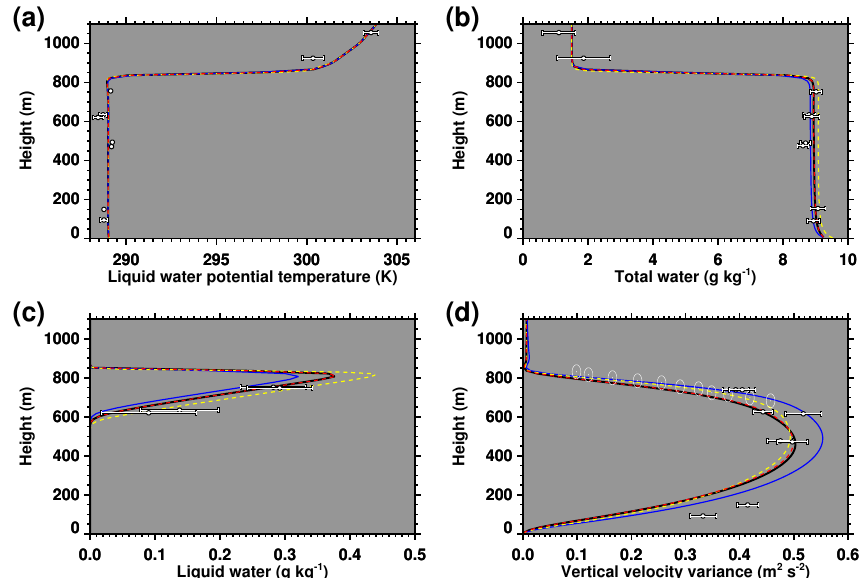
Figure 3. Final state of the spin-up runs (initial states of simulations). Mean final state of the spin-up run m (black), m fine (yellow), l (red), l 1 : 5 (blue). Markers indicate DYCOMS-II RF01 in situ (solid with bar) and radar (ellipse-dot) data (Stevens et al., 2005). Spin-up runs are listed in Table 1.